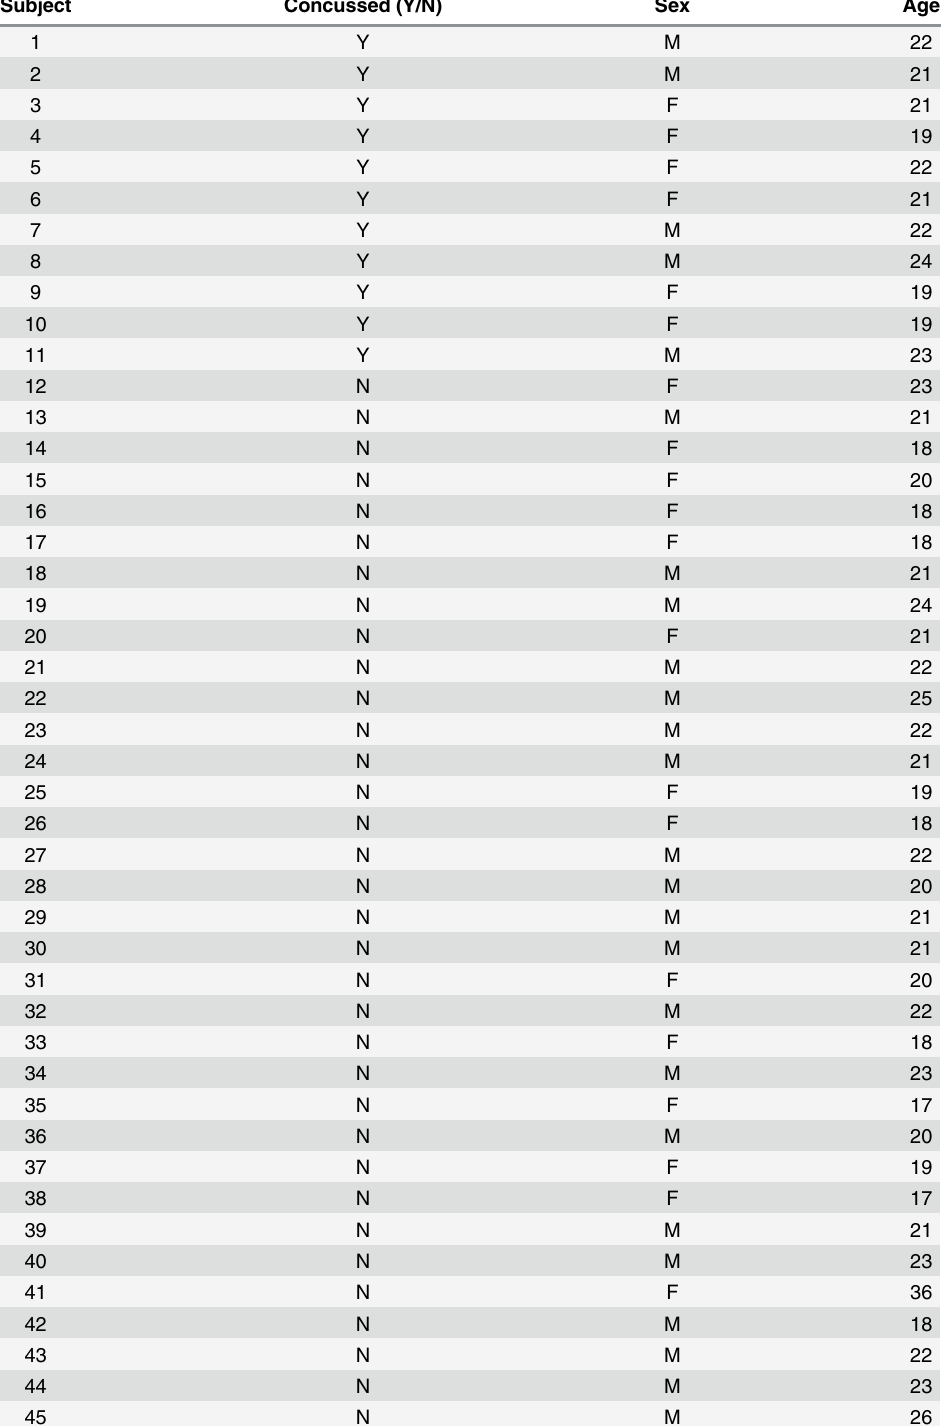
Table 1. Demographic Characteristics for All